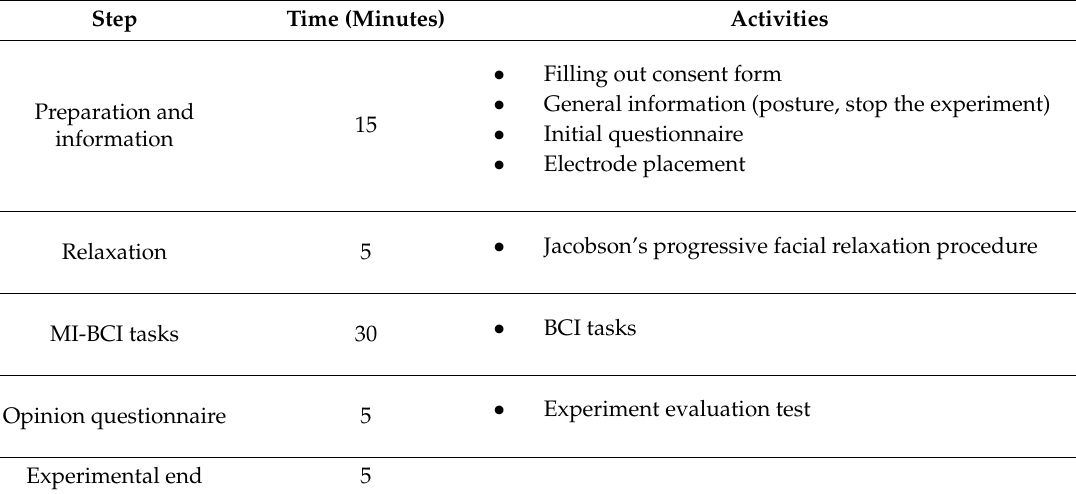
Table 2. Experimental procedure.